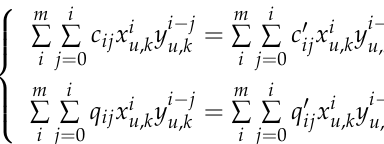
indicate the projection points on im-